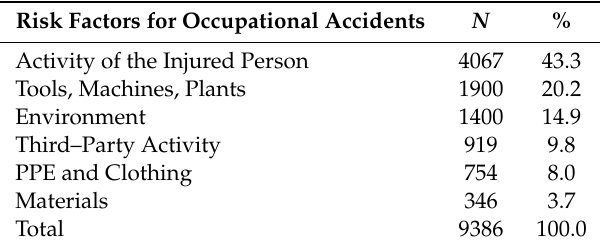
Table 4. Risk factors for fatal occupational injuries. Number ( N ); column percentage (%).